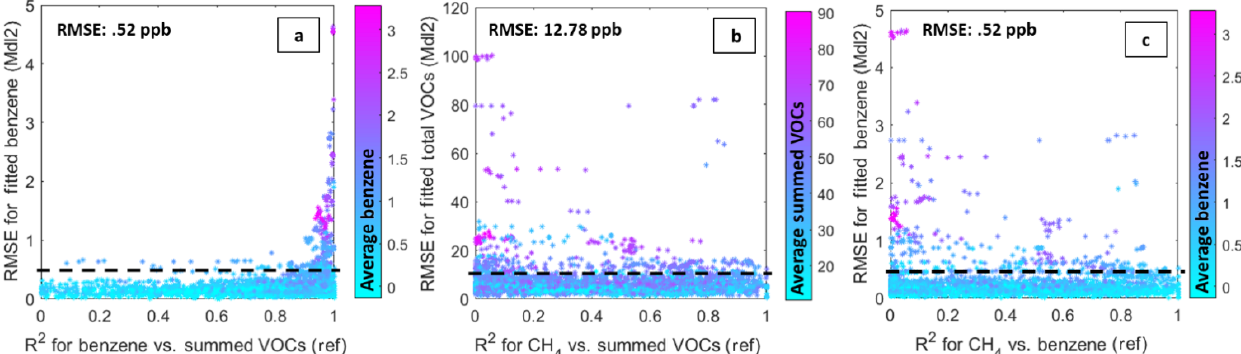
Figure 8. Plots of error (RMSE) versus the coefficient of determination ( R 2 ) for the target VOC or group versus a nontarget potentially confounding VOC or group. These values are calculated on the basis of a 1h moving window and the points are colored according to the average of the target pollutant or group for that hour. The black dotted line on each is the overall RMSE determined in Sect.